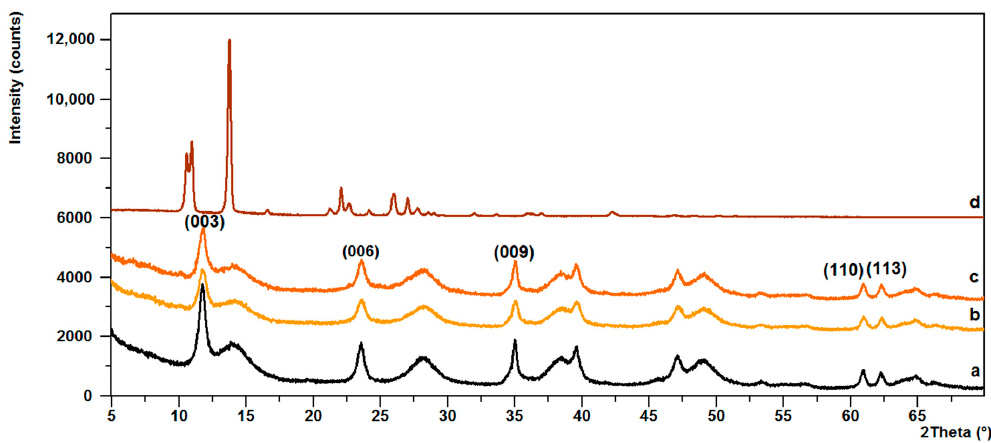
Figure 4. Powder XRD patterns for: LH ( a ), LH/Alizarin (15%) ( b ), LH/Alizarin (20%) ( c ), and alizarin ( d ).